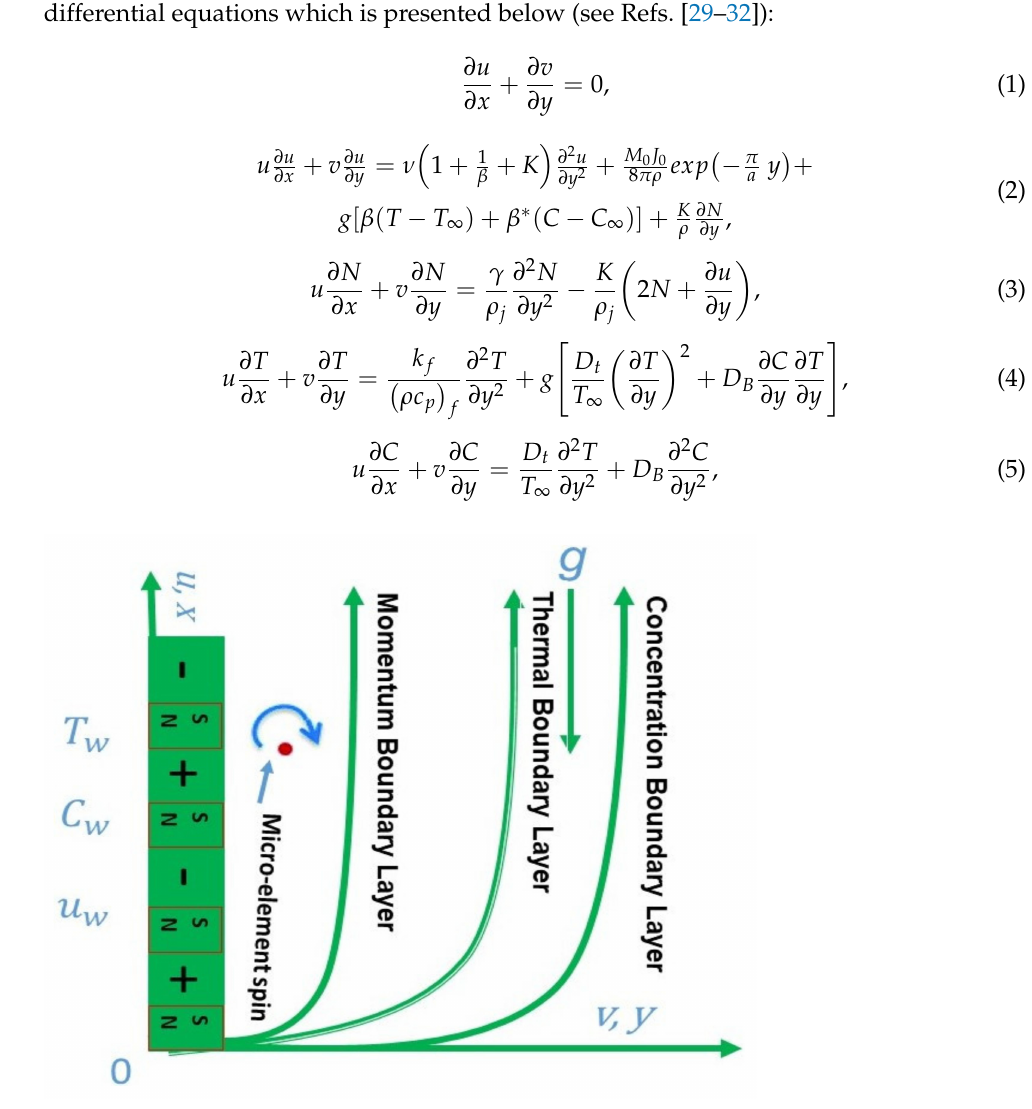
Figure 1. Flow pattern of micropolar–Casson